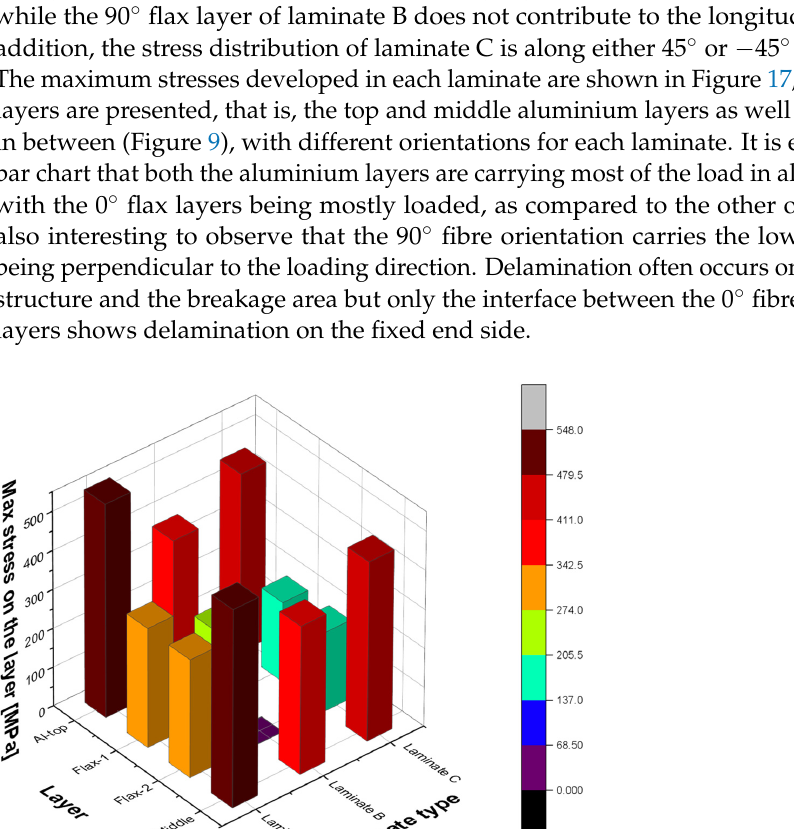
Figure 16. Delamination of each layer of laminate C after failure; ( a ) 1st interface; ( b ) 2nd interface; ( c ) 3rd interface; ( d ) 4th interface; ( e ) 5th interface; ( f ) 6th interface.